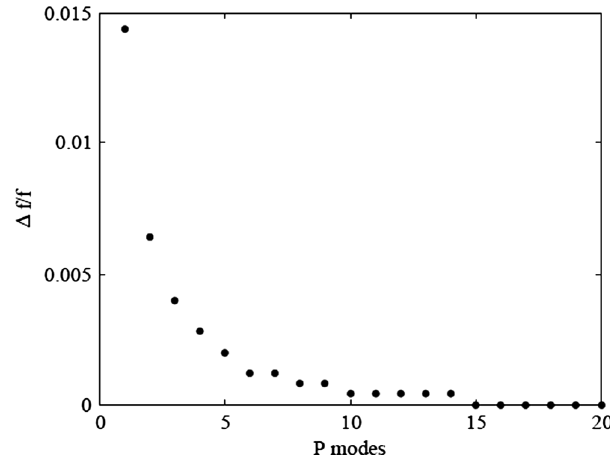
FIG. 2 (color online). Convergence of S modes in mode